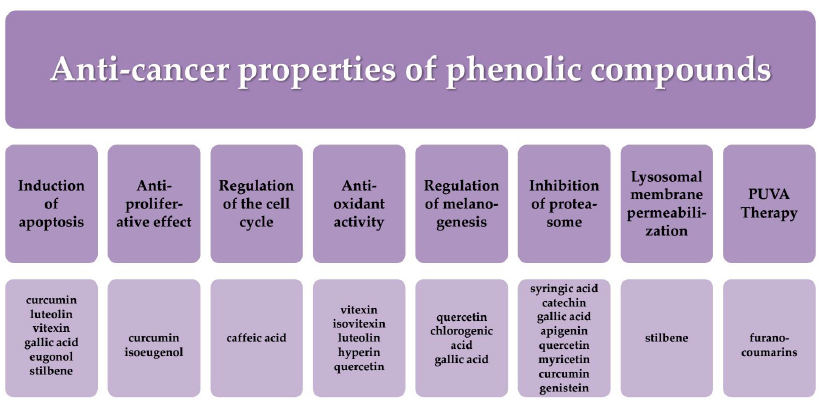
Figure 8. The anticancer properties of phenolic compounds.